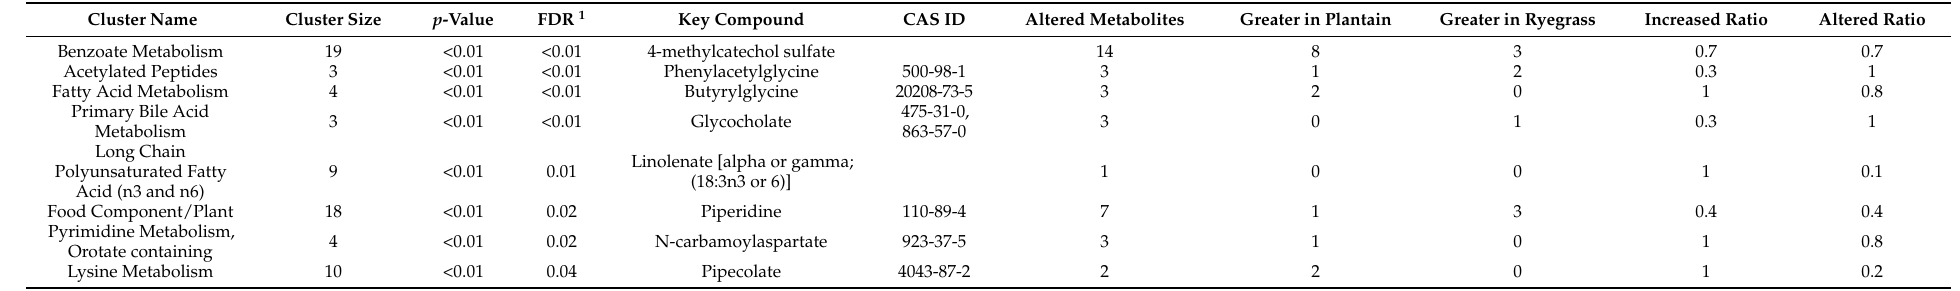
Table 7. Metabolite class identified using chemical similarity enrichment analysis software (ChemRICH https://chemrich.idsl.me/home, accessed on 25 September 2022) for metabolites detected in milk from cows consuming either a plantain or ryegrass diet, plantain is used as the reference diet for this